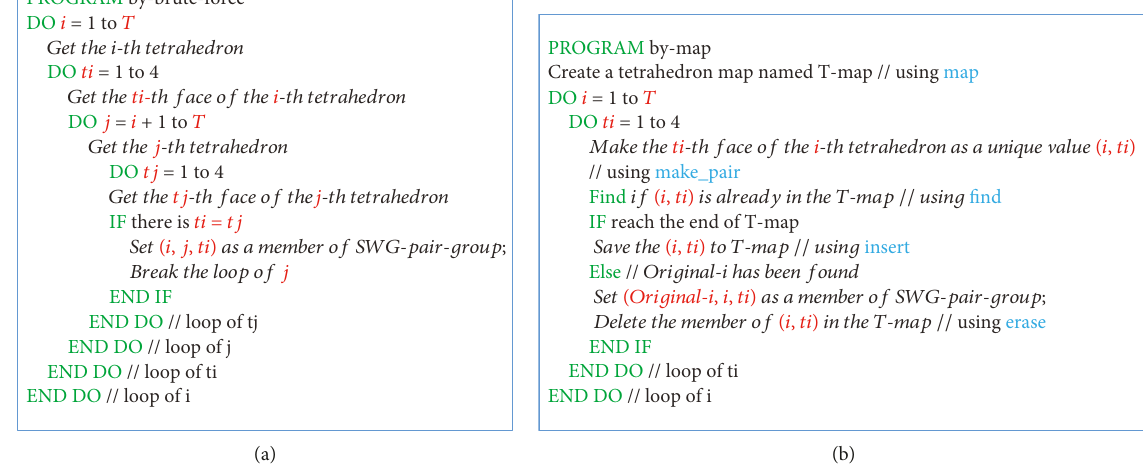
Figure 2: Pseudocode for constructing SWG pairs by (a) the brute-force method and (b) map method. The special function of the map is marked with blue. All pairs of conformal SWG functions are stored in the